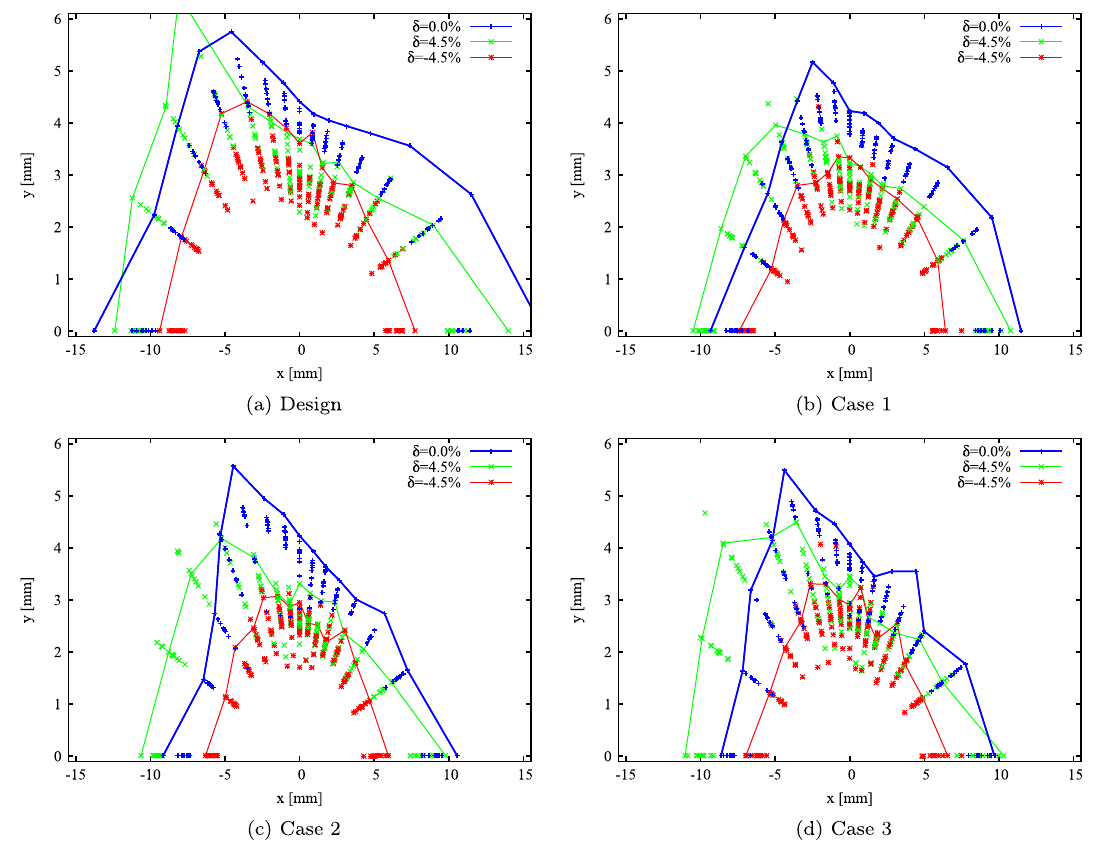
FIG. 13. Dynamic aperture for the ideal lattice and 10 error seeds. (a) shows the design lattice and (b) – (d) show the three SCVDB cases. The DA was calculated at the center of the first long straight section, close to the injection